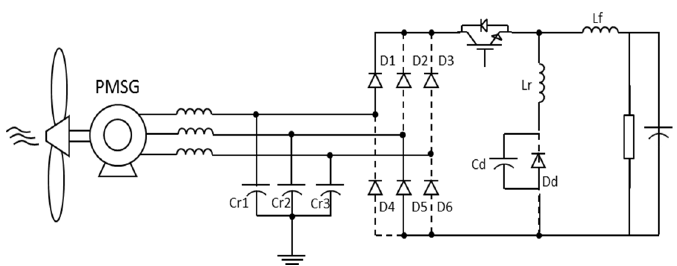
Figure 11. Equivalent circuit: Step 3.